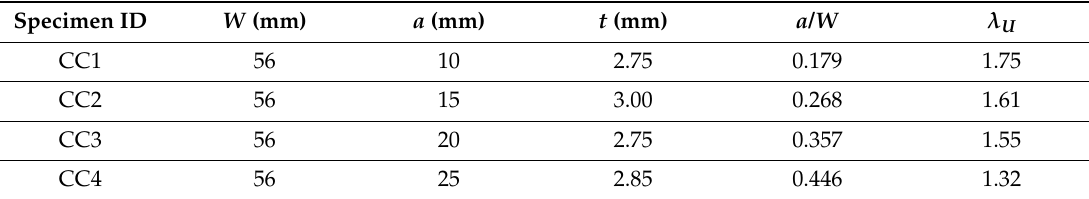
Table 2. Geometric characteristics of the specimens containing a centered crack. The rightmost column contains the ultimate remote stretch before